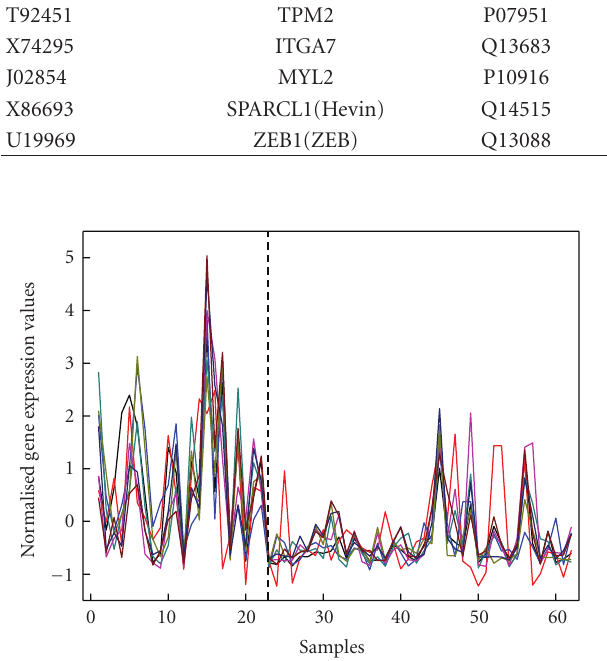
Figure 6: Di ff erentially coexpressed profiles of the eight genes in two kinds of samples; samples 1–22 represent normal samples and samples 23–62 are disease